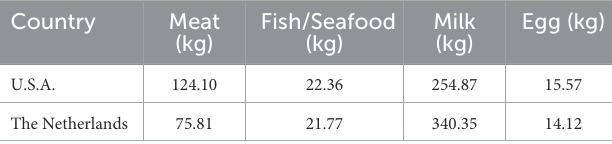
TABLE 1 Meat, fish/seafood, milk, and egg consumption kilograms per capita in 2017. Country Meat Fish/Seafood (kg)